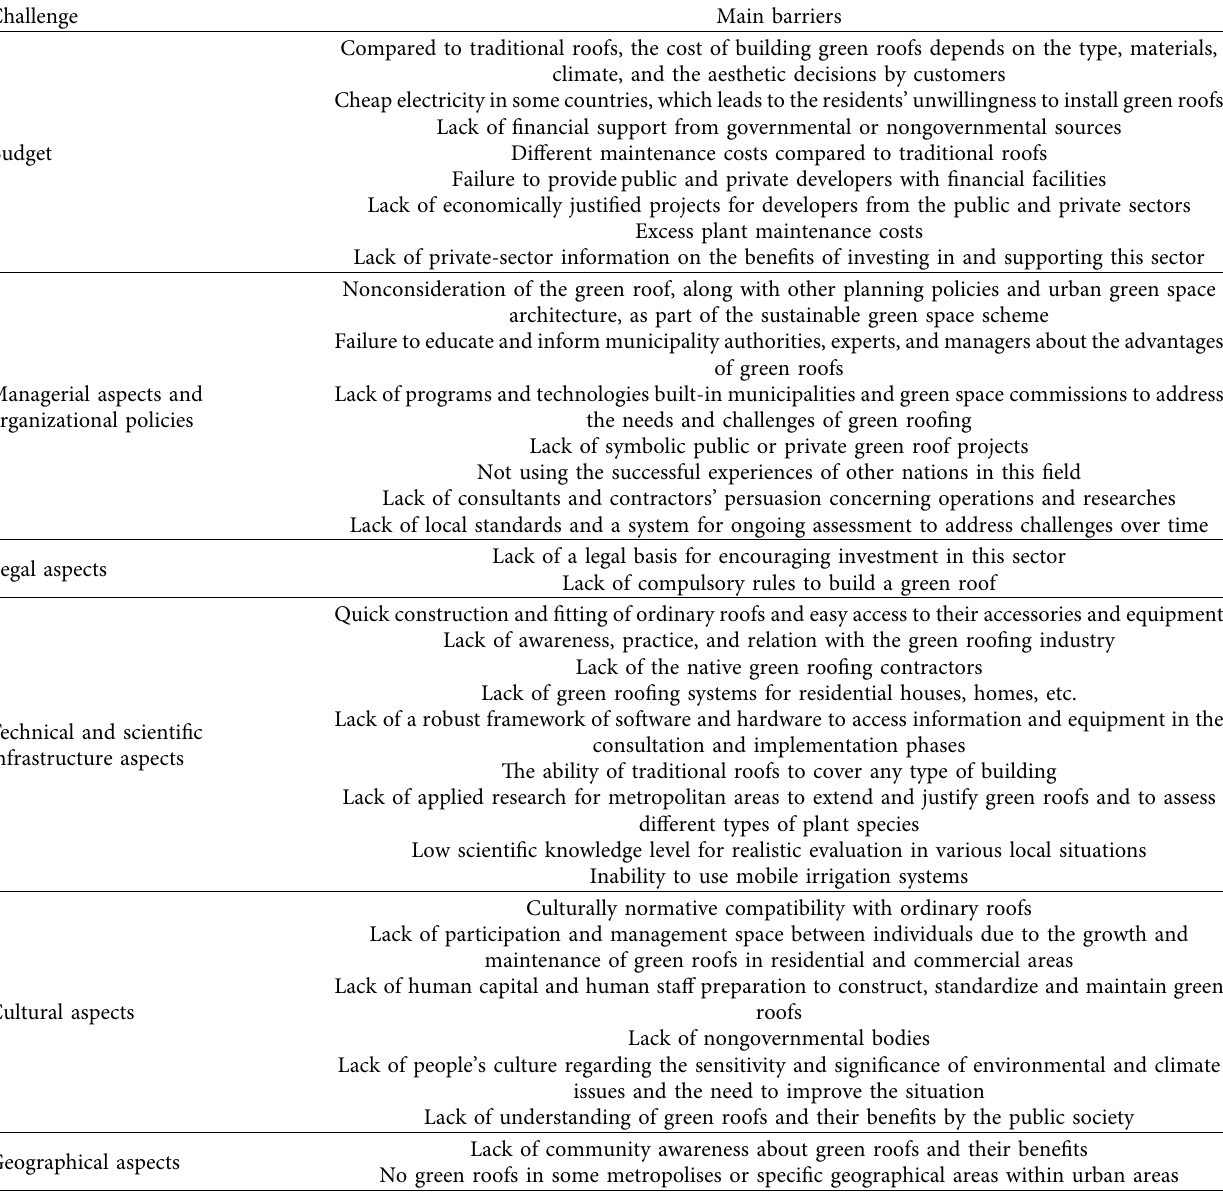
Table 9: Challenges and downsides of using green